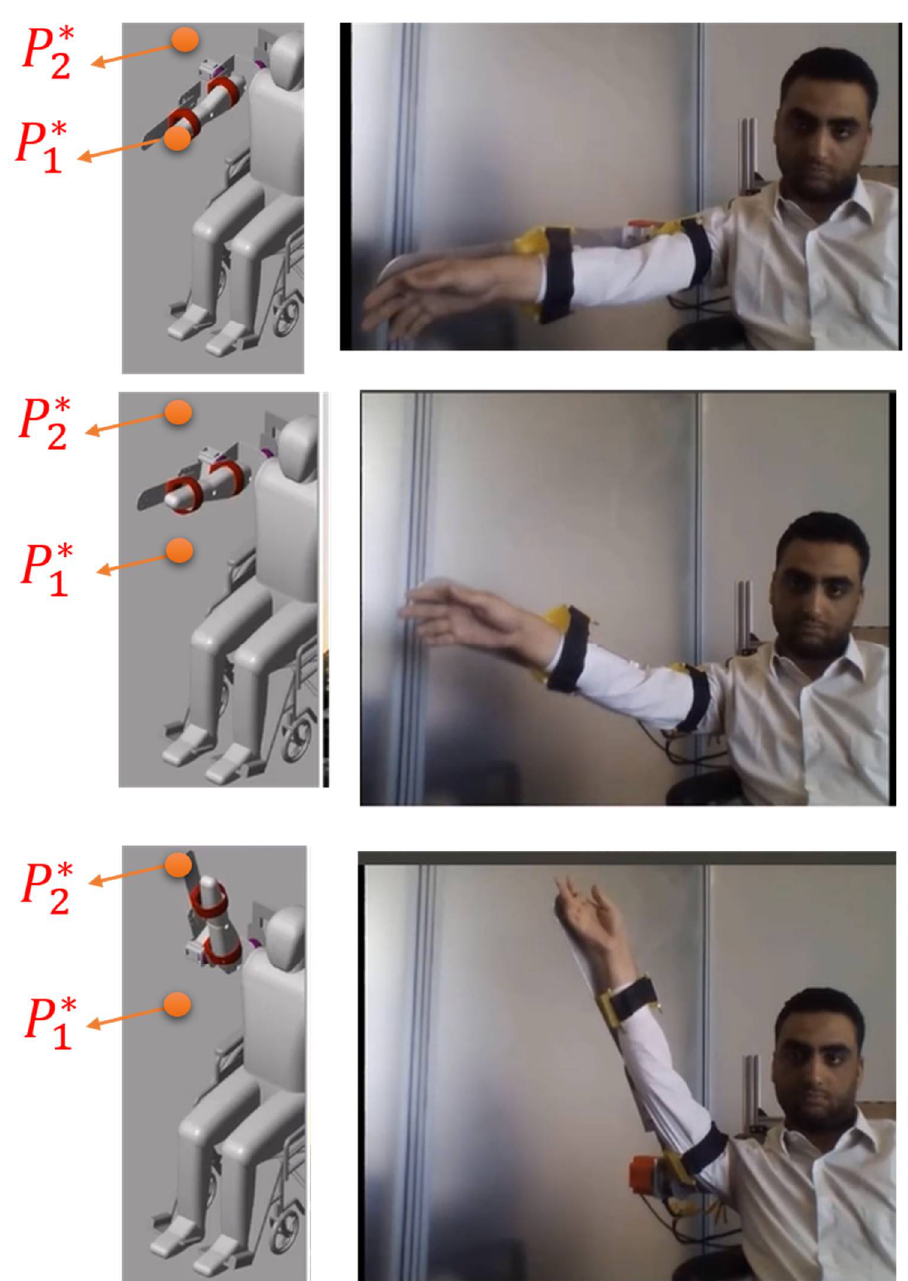
Figure 23. The input trajectory drives the motors of the exoskeleton and the dynamic model simul-